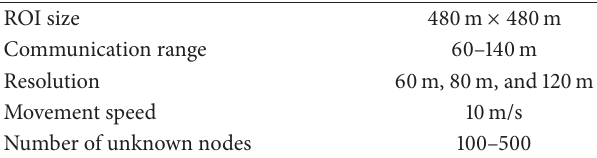
Table 1: Parameters used in the